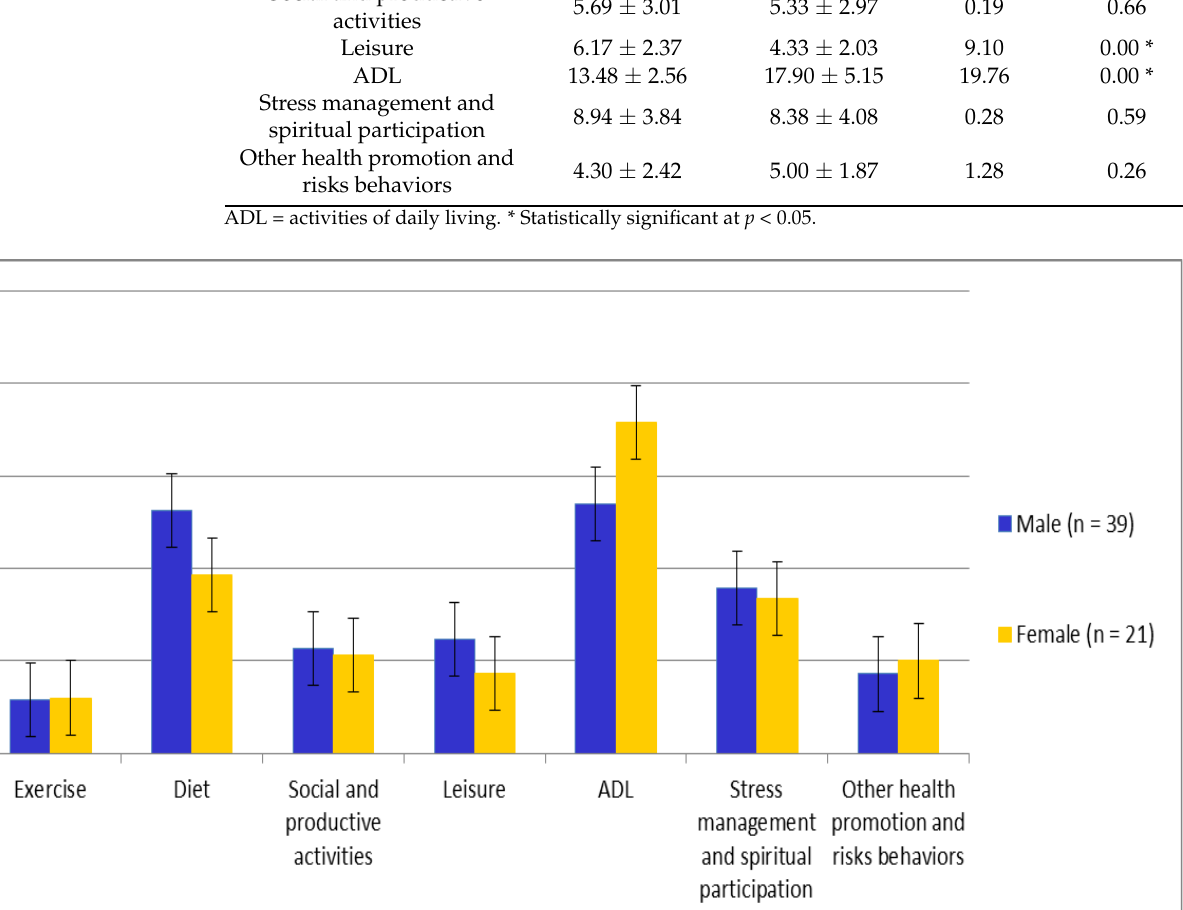
Table 3. Lifestyle differences between the sexes (N = 60).